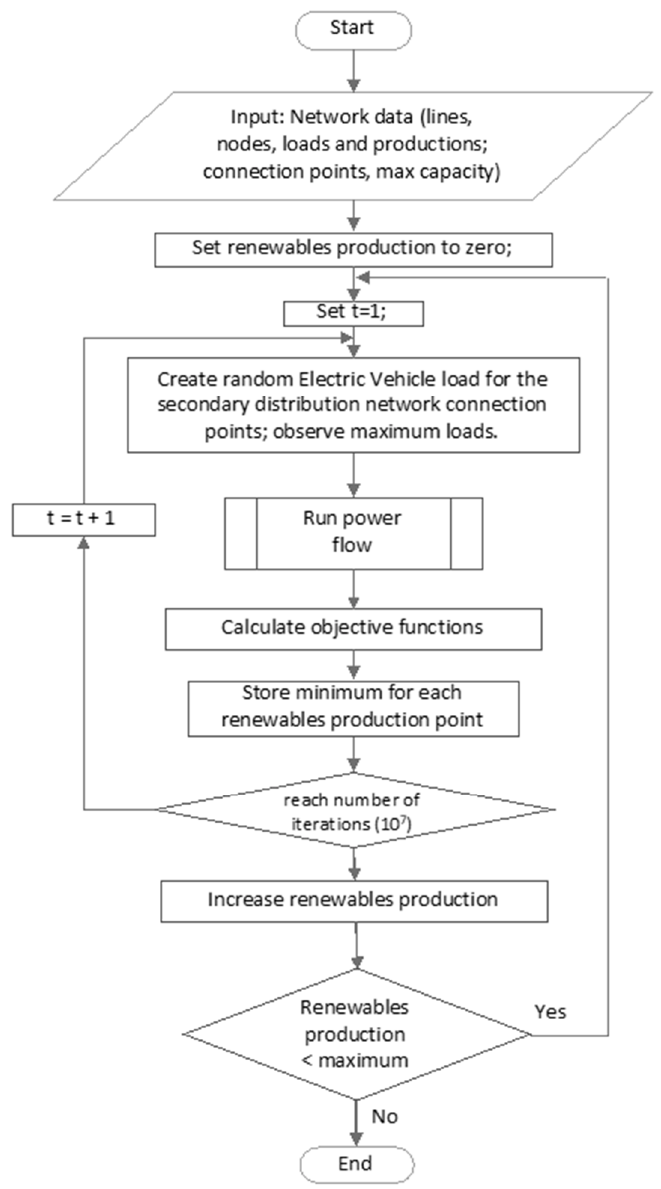
Figure 1. Calculating operational points optimization formula minimums.